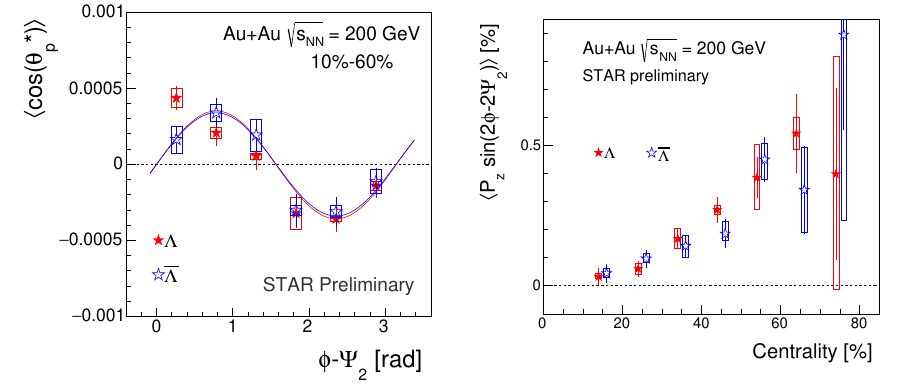
) and as a function of Λ ( Λ ) hyperons’s azimuthal angle φ relative Figure 2: Left panel: cos( θ ⋆ p to the second-order event plane for 10-60% centrality bin in Au + Au collisions at √ s NN = 200 GeV. Open boxes show the systematic uncertainties. Note that the resolution on Ψ 2 is not corrected here. Right panel: Sine modulation of polarization along the beam direction relative to the second-order event plane as a function of centrality in Au + Au collisions at √ s NN = 200 GeV. Open boxes show the systematic